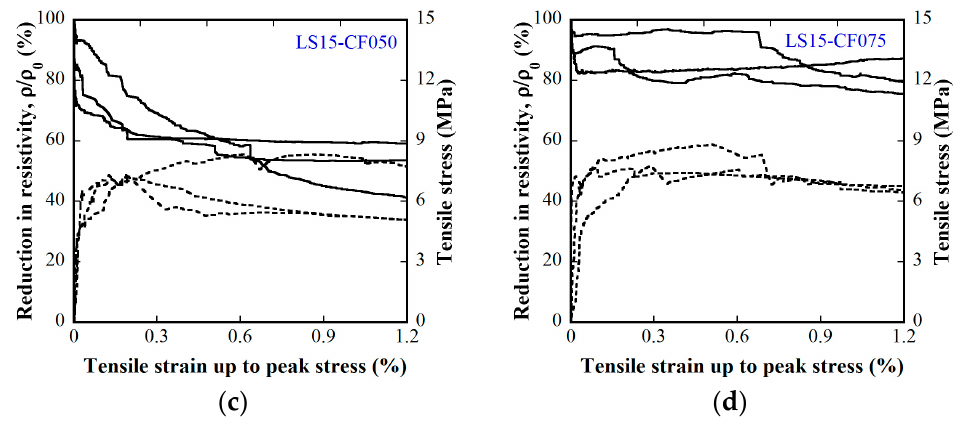
Figure 16. Influence of carbon fiber content on electro-tensile behaviors of the MSFRC2 group (stress–strain: dashed curve, reduction in resistivity–strain: solid curve): ( a ) 1.5% smooth fibers & carbon fibers 0.0%; ( b ) 1.5% smooth fibers & 0.25% carbon fibers; ( c ) 1.5% smooth fibers & 0.50% carbon fibers; ( d ) 1.5% smooth fibers & 0.75% carbon fibers.